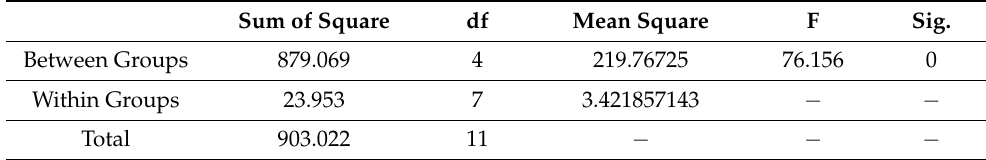
Table 1. Tensile strength for all samples using ANOVA method. Sum of Square df Sig. Between Groups Within